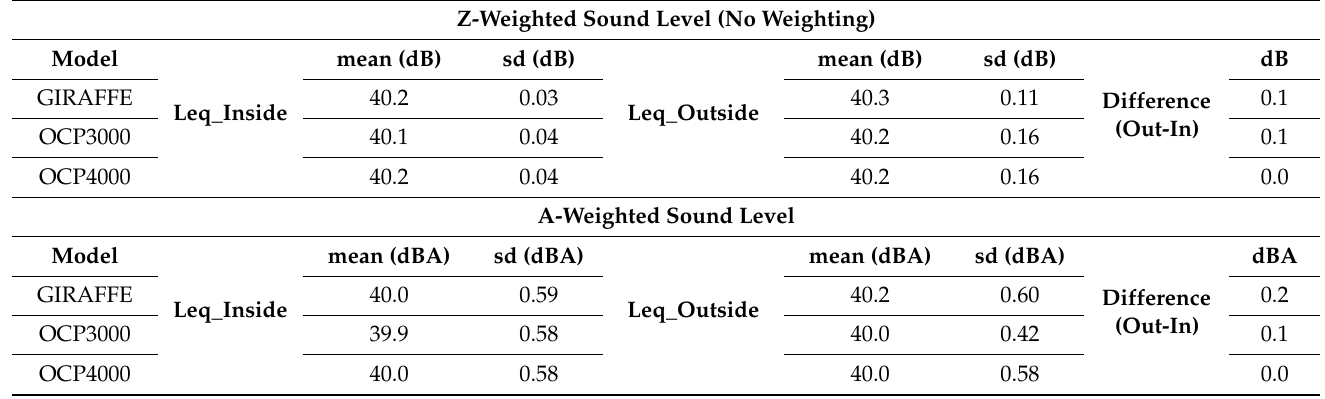
Table 1. The overall noise level inside and outside the incubators. Background noise (Incubators off). Z-Weighted Sound Level (No